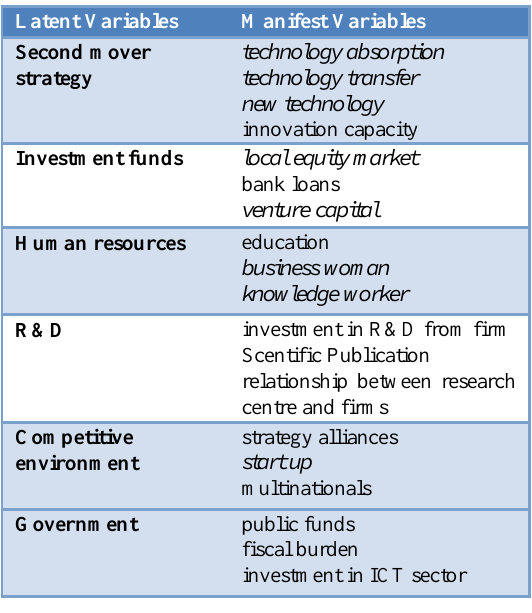
Table 1: Latent Variables and Manifest